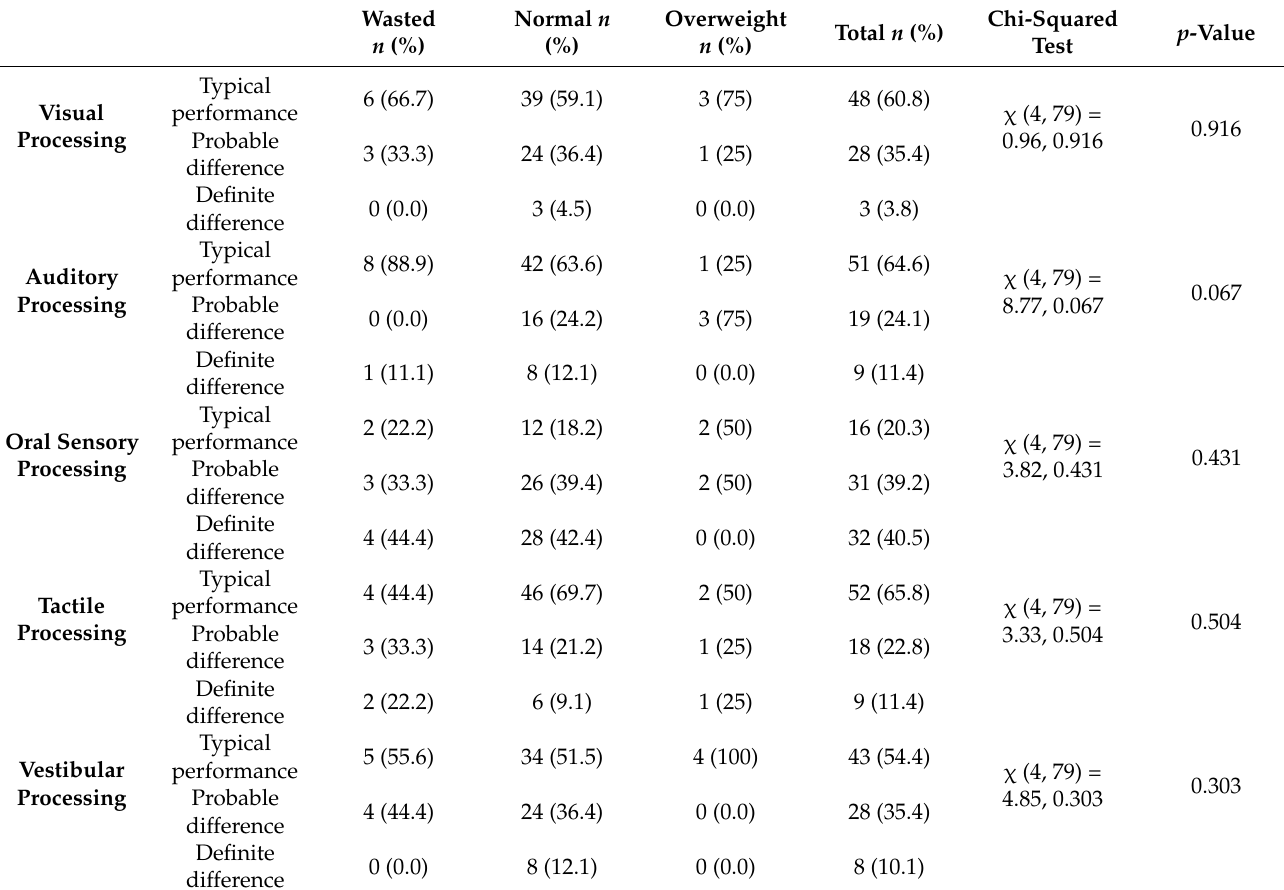
Table 4. Relationship between BMI-for-age anthropometric index (z-score) and sensory